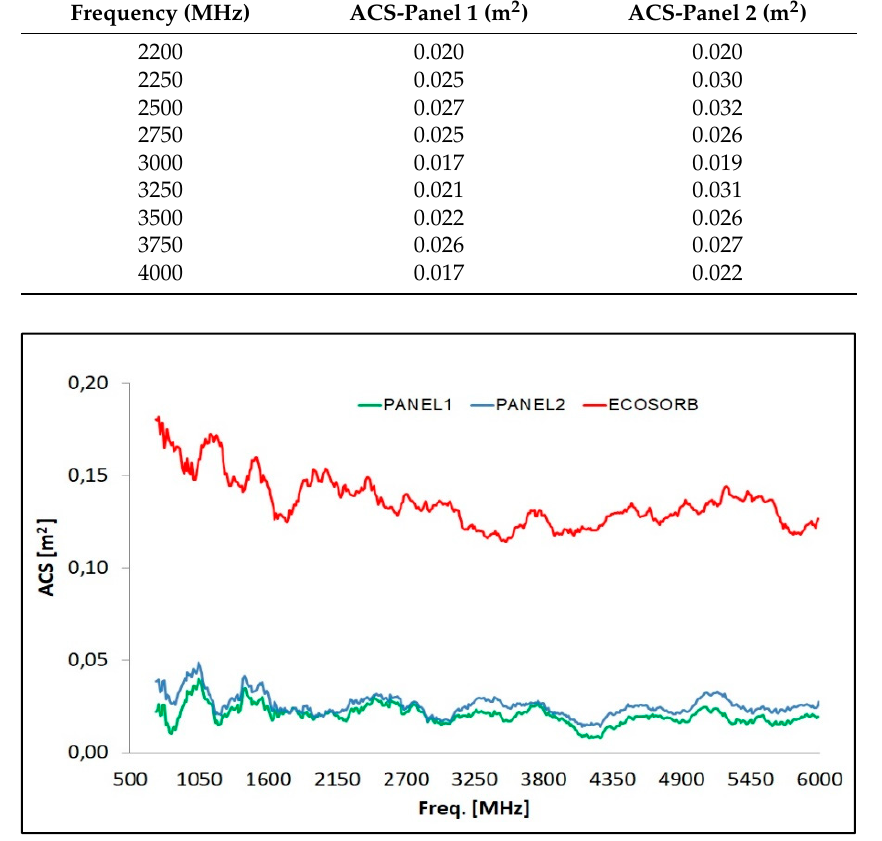
Figure 13. ACS of the micro- and nano-filled multilayered panels within the microwave S-band.